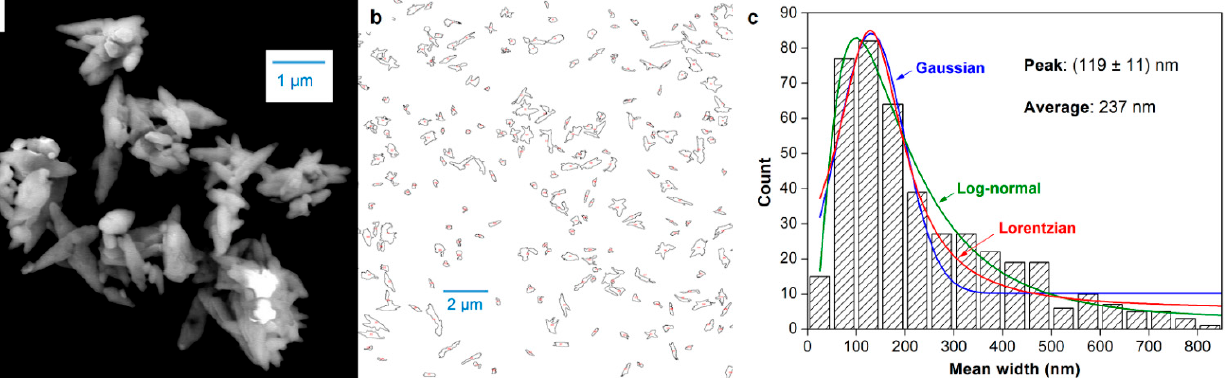
Figure 3. Cellulose nanocrystals and their aggregates: micrograph of a CNC cluster ( a ), outlined particles after binarization in ImageJ ( b ), and width histogram by counts, including fitting to Gaussian, Lorentzian, and log-normal distributions ( c ).